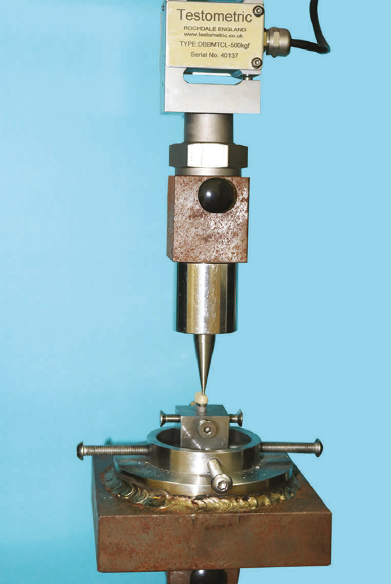
Figure 6: Metal tooth analog-crown-metal jig assembly mounted on universal testing machine (Testometric M350-5CT, Rochdale, United